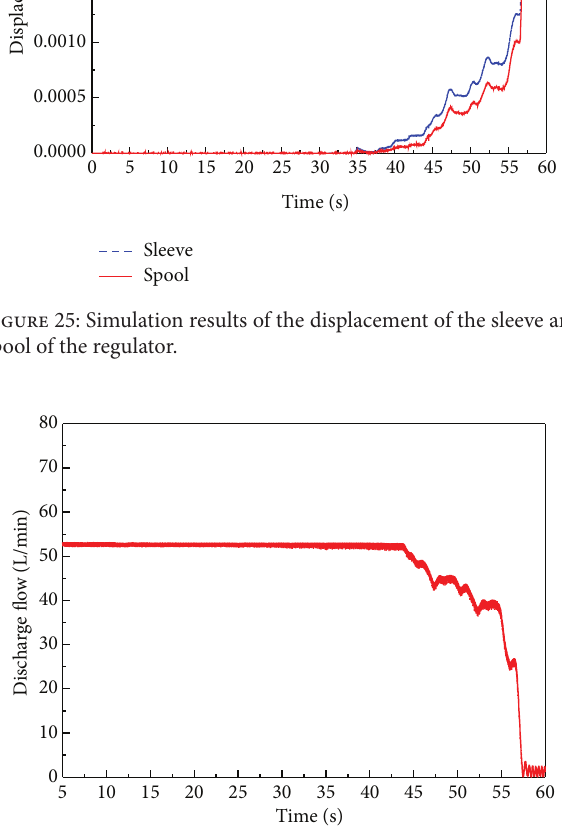
Figure 26: Output of discharge flow through simulation with modified counterbalance shape.